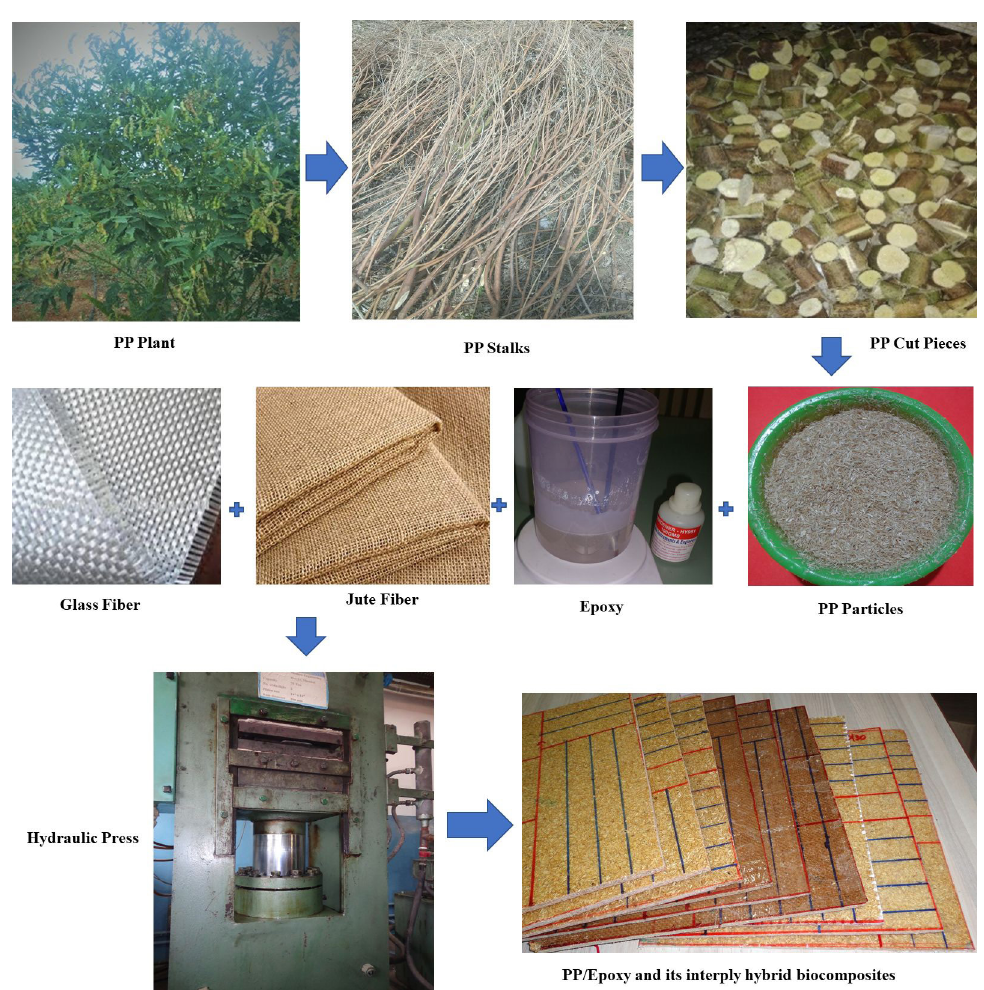
Figure 1. Preparation of PP stalk particles and the development of EP composites and their hybrid